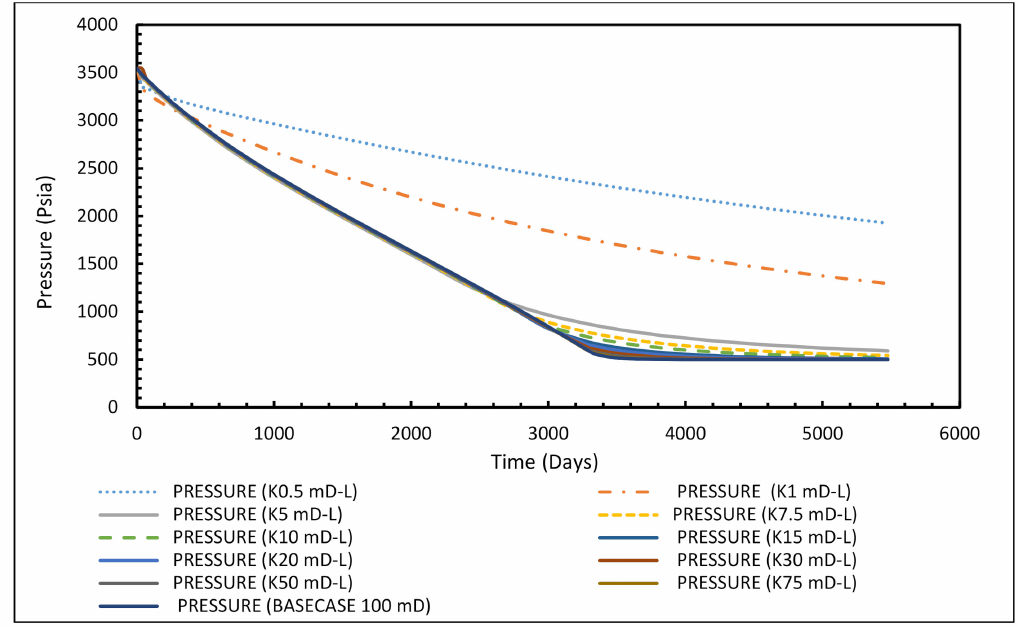
Figure 3. Reservoir pressure versus time at the wellbore for local grid